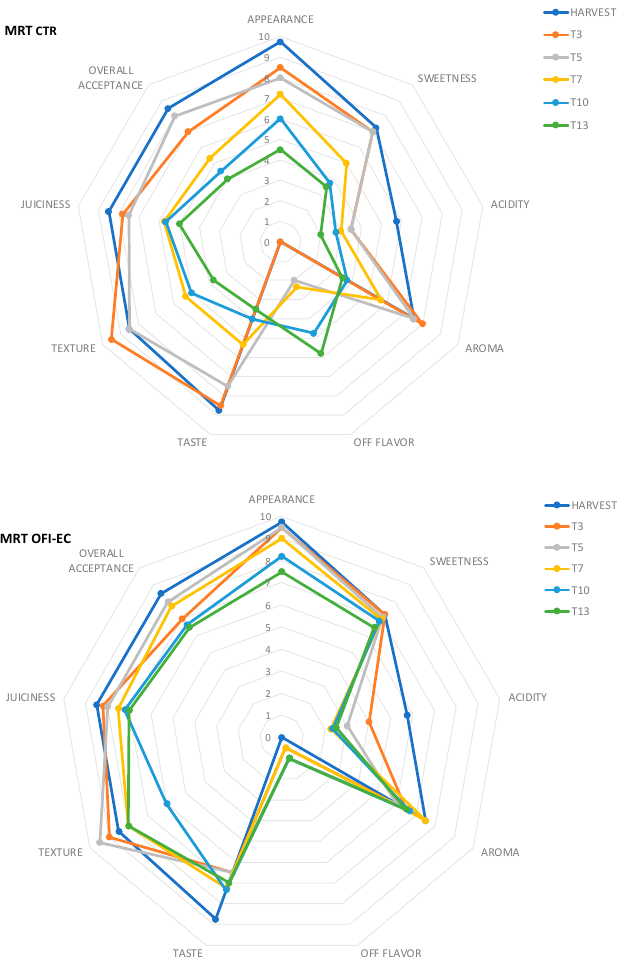
Figure 6. Sensorial analysis of minimally processed Martorana loquat fruit, untreated fruit (MRT CTR), and fruit treated with mucilage (MRT OFI-EC) after 3 (T3), 5 (T5), 7 (T7), 10 (T10), and 13 (T13) days of cold storage at 5 °C. Data are the mean ± SE ( n = 5 ).